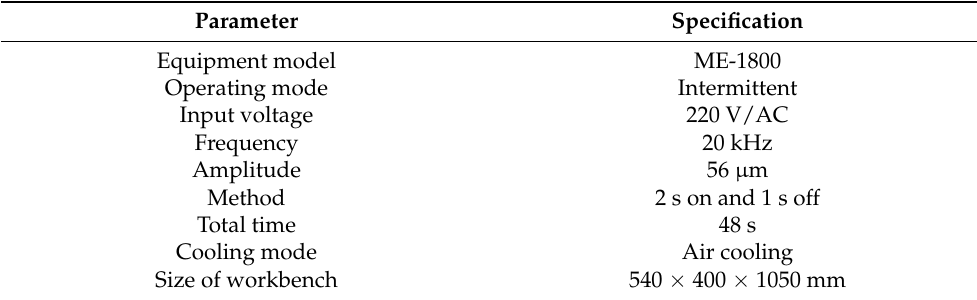
Figure 2. The schematic of the ultrasonic process. Table 1. Specifications of the ultrasonic process.